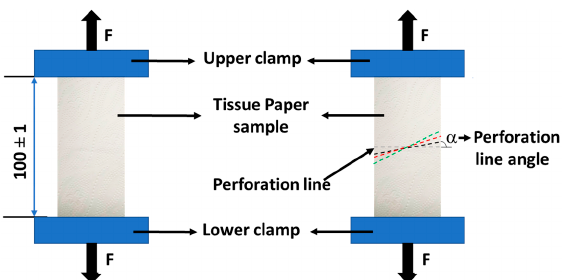
Figure 4 . Experimental set-up to test non-perforated and perforated toilet papers. (F shows the force direction applied in the tensile test).